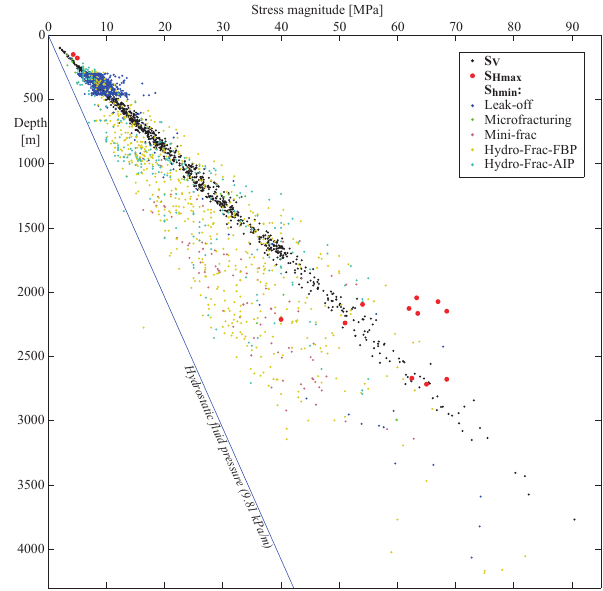
Figure 12. Depth plot of the in situ stress magnitudes. These are 981 S V magnitude data (black), 1720 S hmin magnitudes (several colours), and 2 measured as well as 11 calculated S Hmax magni- tudes (highlighted red points). S hmin data are colour coded depend- ing on the test type, which is taken over from the original